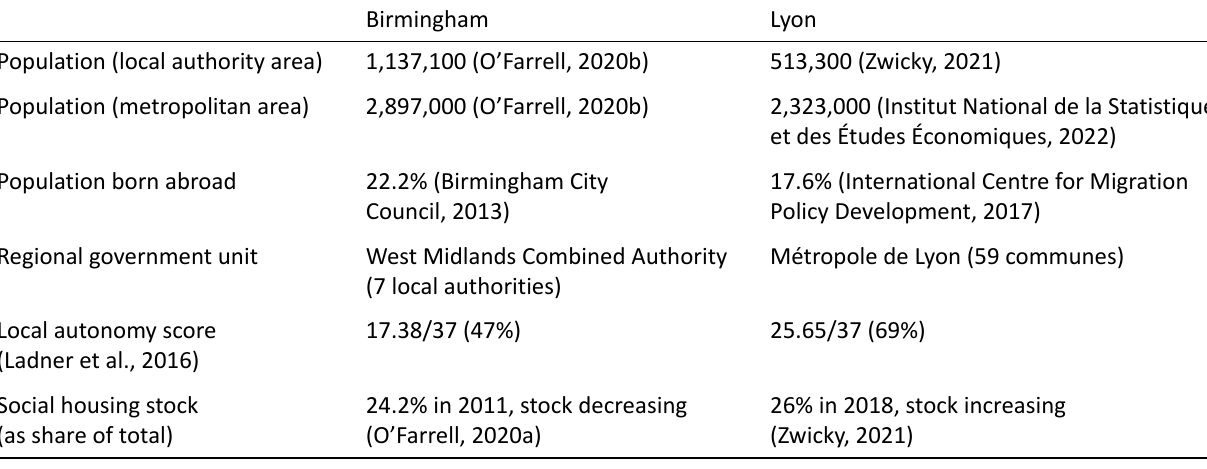
Table 1. Overview of the two case